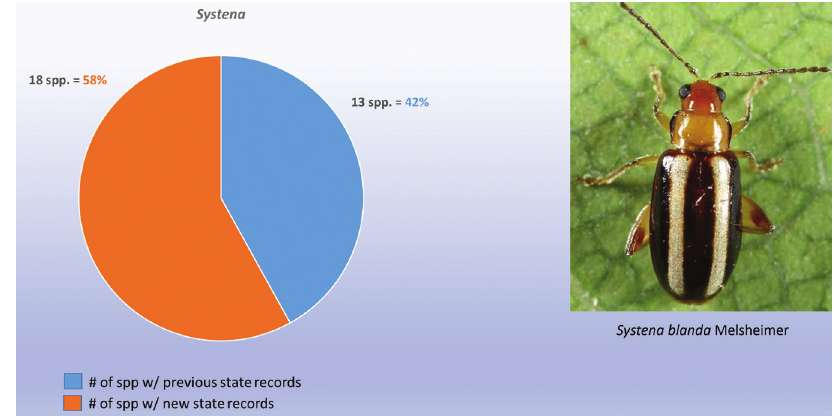
Figure 8. Systena Chevrolat new state records versus previously recorded state records.